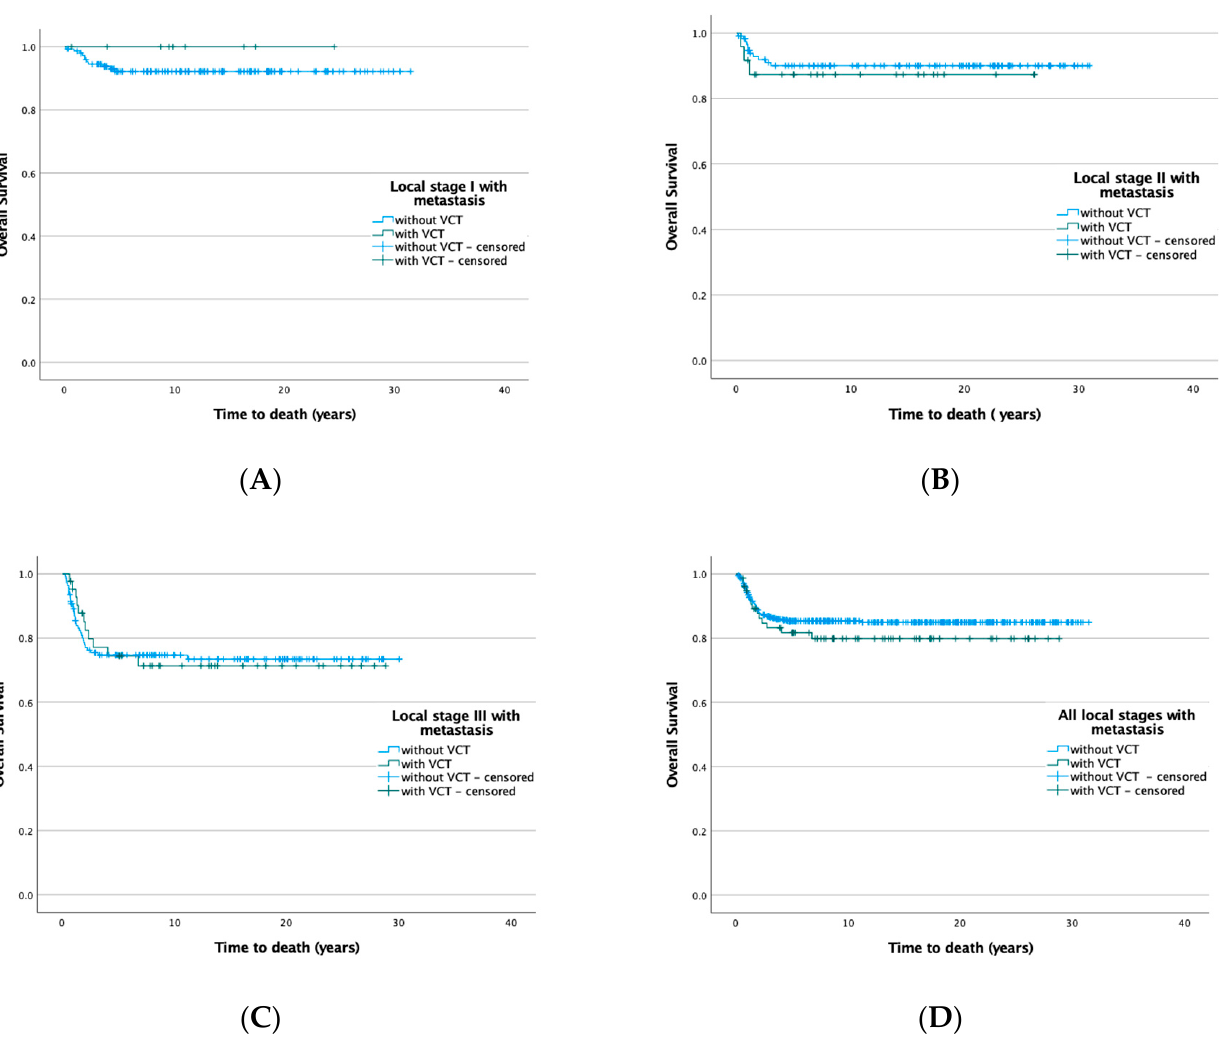
Figure 1. Overall survival with and without VCT depending on local stages in patients with metastatic disease. ( A ) Local stage I (no VCT 92.6%, VCT 100, p = 0.424); ( B ) local stage II (no VCT 90.5%, VCT 87.5, p = 0.631); ( C ) local stage III (no VCT 74.8%, VCT 74.4, p = 0.961); ( D ) all stages (no VCT 85.7%, VCT 81.8, p = 0.341).